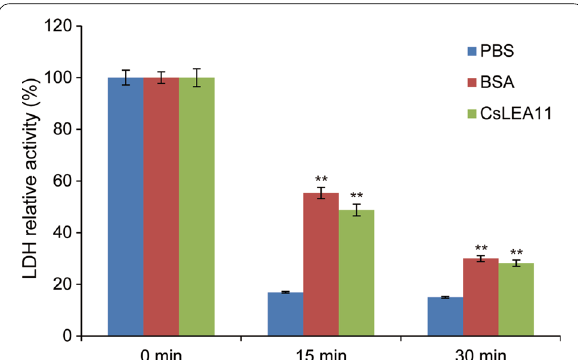
Fig. 7 Protection of LDH activity by CsLEA11 protein from inactiva- tion under heat stress. The relative activity of LDH during heating at 65 °C for 15 and 30 min. The LDH activity and standard deviations are based on three independent